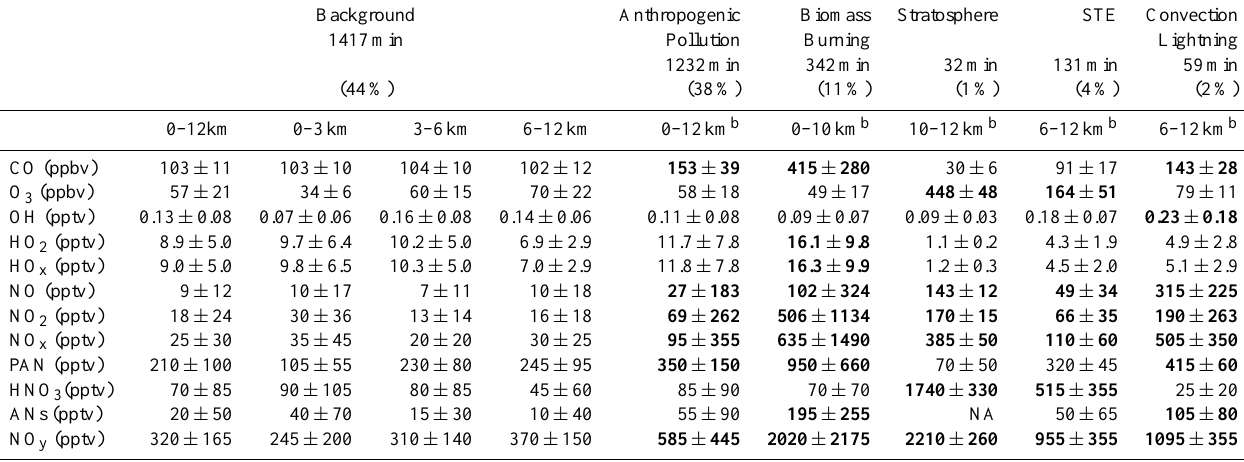
Table 3b. Same as Table 3a but for ARCTAS-B a